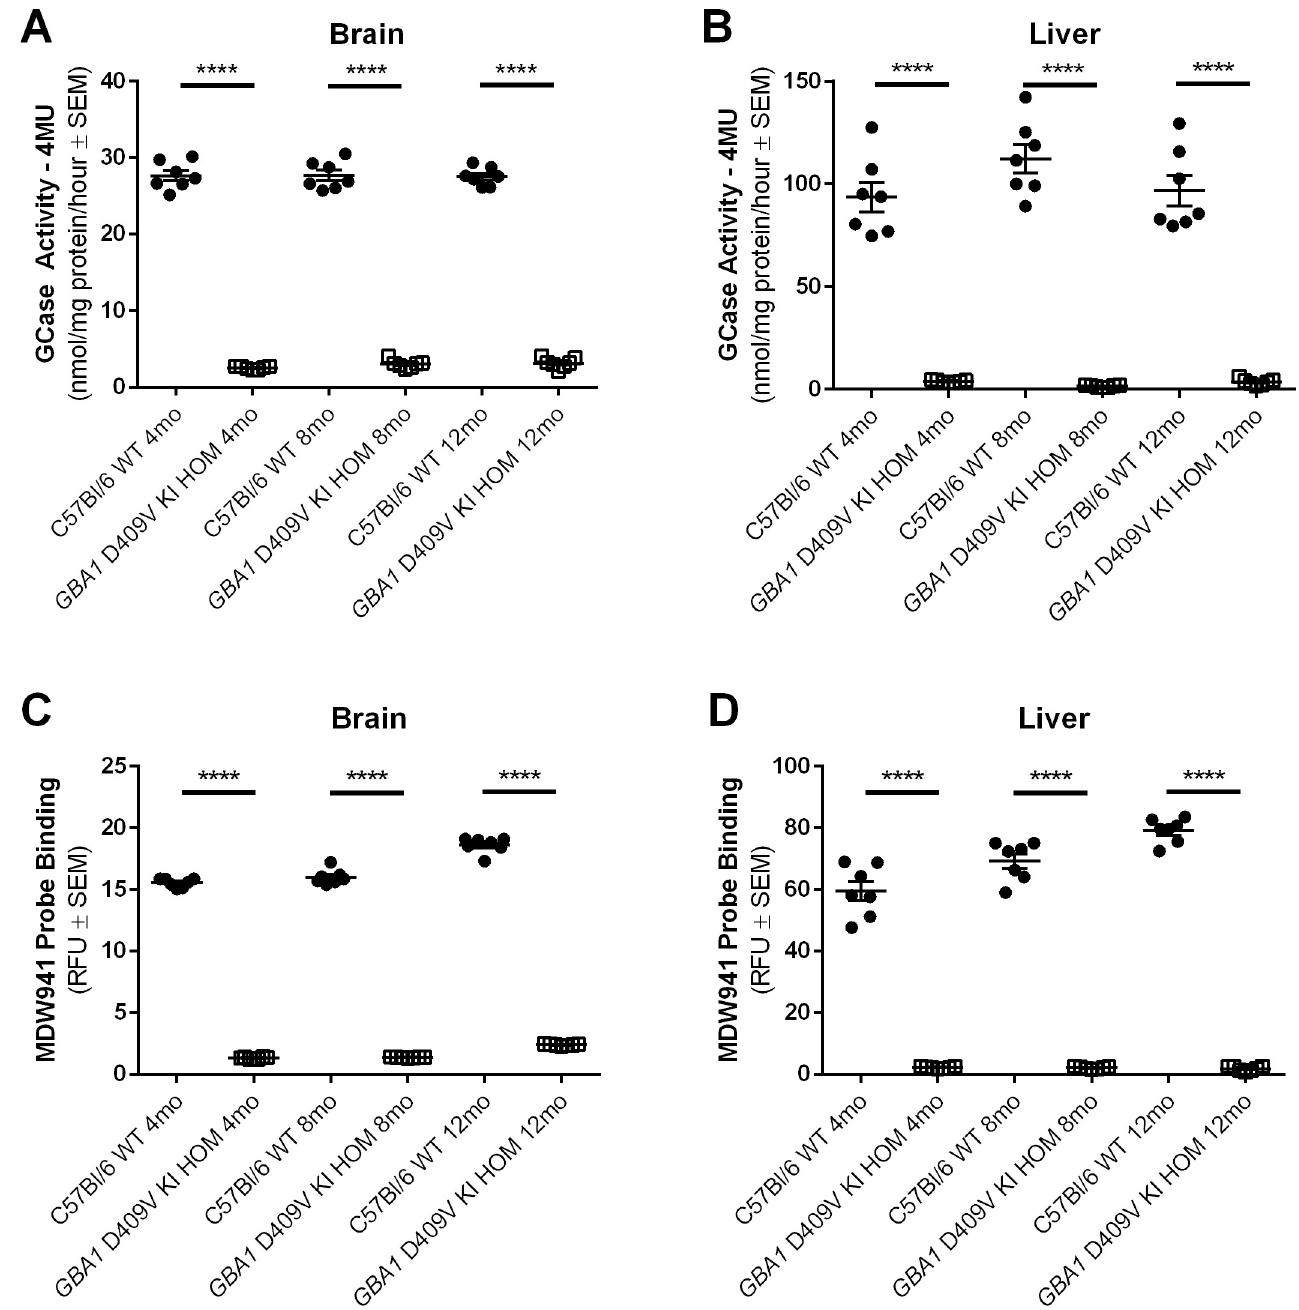
Fig 3. GCase activity is significantly decreased in the brain and liver of the homozygous GBA1 D409V KI mouse model at 4, 8, and 12 months of age. Two independent groups evaluated GCase activity in whole brain homogenate (A,C) and liver homogenate (B,D) using different methods—The CBE/4-MU method (A,B) and the MDW941 method (C,D). In whole brain homogenate (A,C) and liver homogenate (B,D), GCase activity is significantly decreased in the GBA1 D409V KI homozygous (HOM) mice as compared to C57Bl/6 wild type (WT) mice (n = 7/group). GCase activity measured by 4-MU in brain (A) measured as follows: WT 4mo 27.63 ± 0.68, HOM 4mo 2.53 ± 0.07, WT 8mo 27.65 ± 0.69, HOM 8mo 3.01 ± 0.20, WT 12 mo 27.49 ± 0.46, HOM 12mo 3.15 ± 0.26. GCase activity measured by 4-MU in liver (B) measured as follows: WT 4mo 93.69 ± 7.16, HOM 4mo 3.90 ± 0.21, WT 8mo 112.40 ± 6.84, HOM 8mo 1.50 ± 0.19, WT 12 mo 96.79 ± 7.44, HOM 12mo 3.50 ± 0.58. GCase activity measured by MDW941 in brain (C) measured as follows: WT 4mo 15.54 ± 0.13, HOM 4mo 1.33 ± 0.04, WT 8mo 15.99 ± 0.23, HOM 8mo 1.36 ± 0.02, WT 12 mo 18.61 ± 0.24, HOM 12mo 2.37 ± 0.02. GCase activity measured by MDW941 in liver (D) measured as follows: WT 4mo 59.48 ± 3.14, HOM 4mo 2.15 ± 0.10, WT 8mo 69.27 ± 2.36, HOM 8mo 2.03 ± 0.13, WT 12 mo 79.14 ± 1.48, HOM 12mo 1.79 ± 0.29. Significant differences are indicated as follows: ���� p < 0.0001. Abbreviations: SEM, standard error of the mean; RFU, relative fluorescence units; GBA1 , gene encoding human glucocerebrosidase; GCase, glucocerebrosidase; WT, wild type; HOM, homozygous; KI, knockin; mo, month.